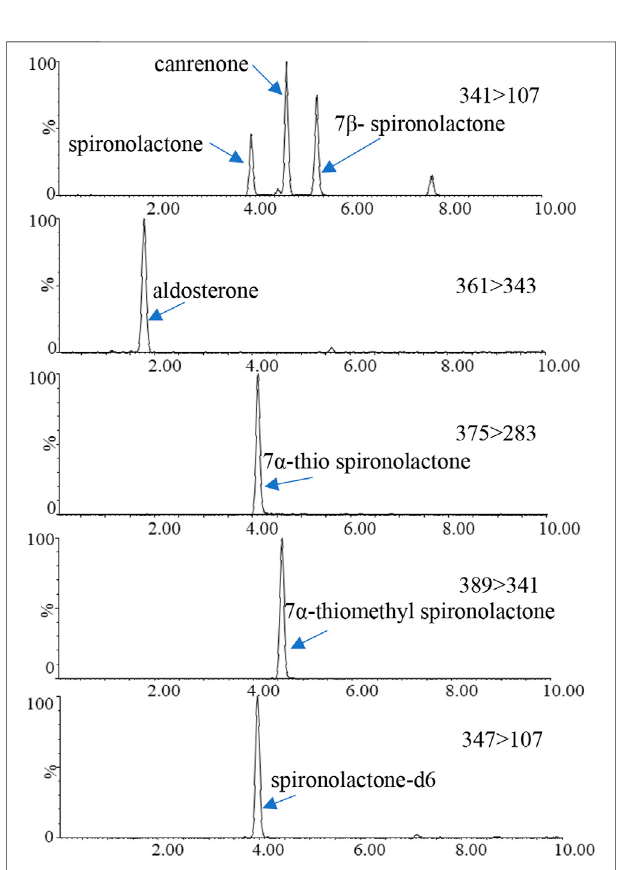
FIGURE 3 | Typical UPLC-MS/MS chromatograms of the target mineralocorticoid standards.